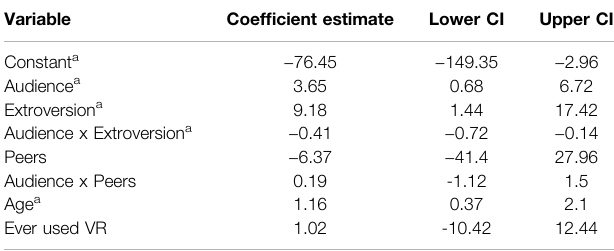
TABLE 1 | Linear model of predictors of Anxiety (N (cid:1)